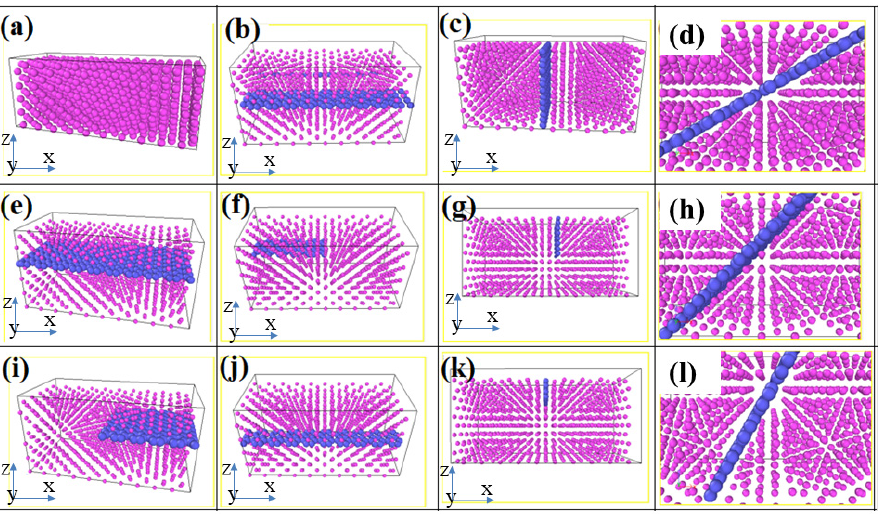
Figure 8. Schematic representation of graphene distribution in graphene/aluminum